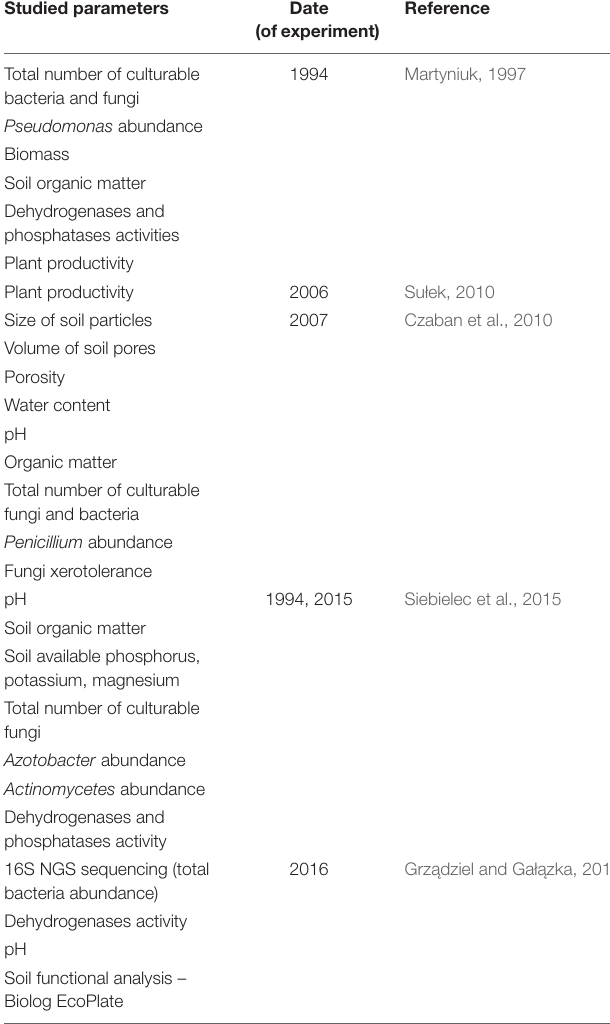
TABLE 1 | Historical studies on soils collected in microplots founded in 1881 in Puławy. Studied parameters